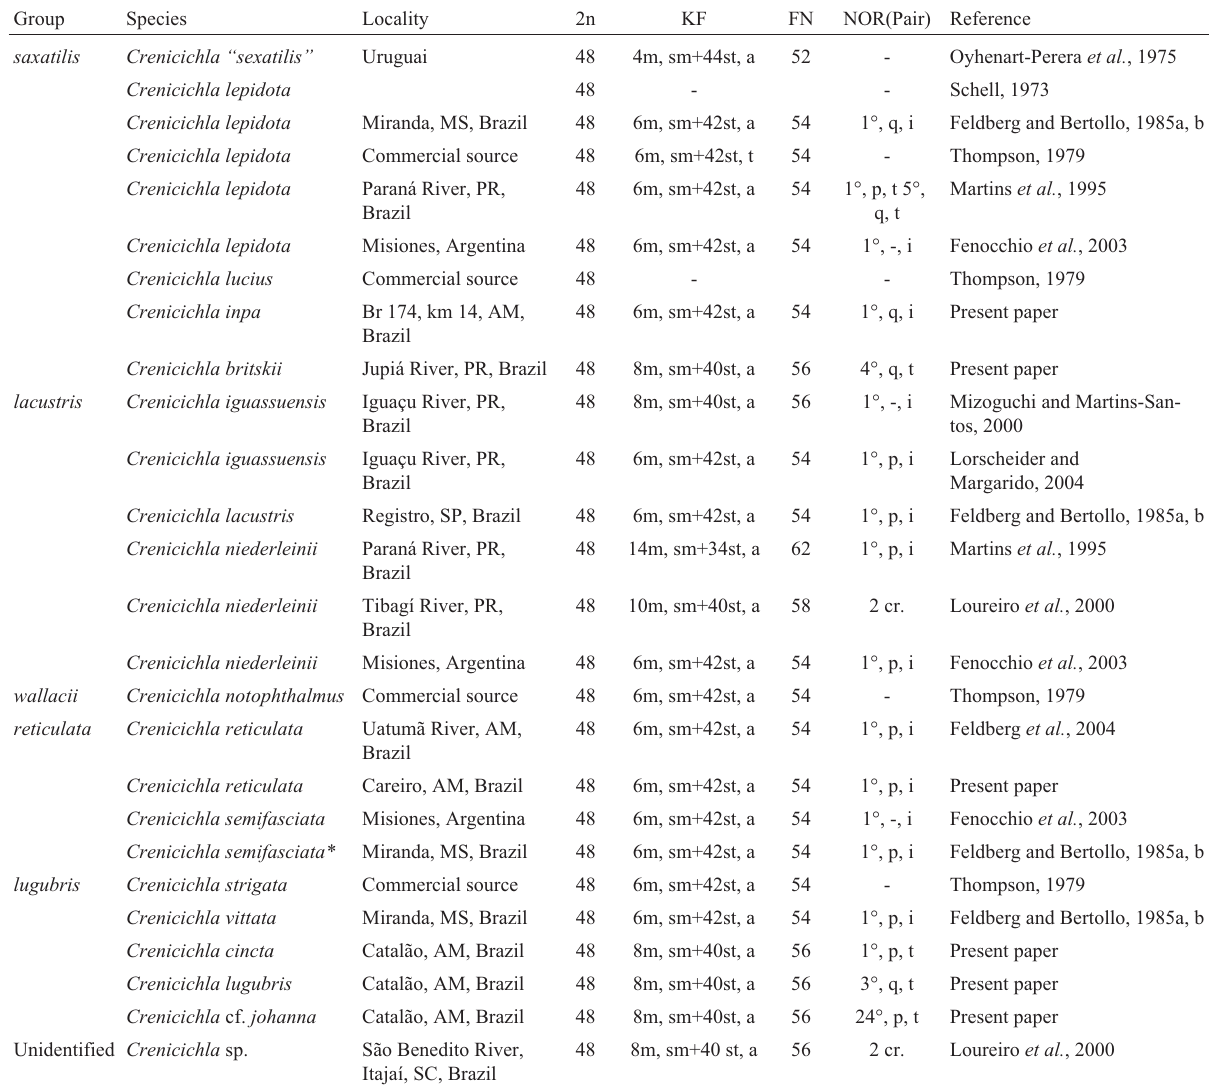
Table 1 - Chromosome characteristics in the genus Crenicichla (2n = diploid number; KF = karyotypic formula; FN = fundamental number; NOR = Nu- cleolar organizer region, p = short arm, q = long arm, t = terminal, i = interstitial; * = updated species names as shown in the Fish Database